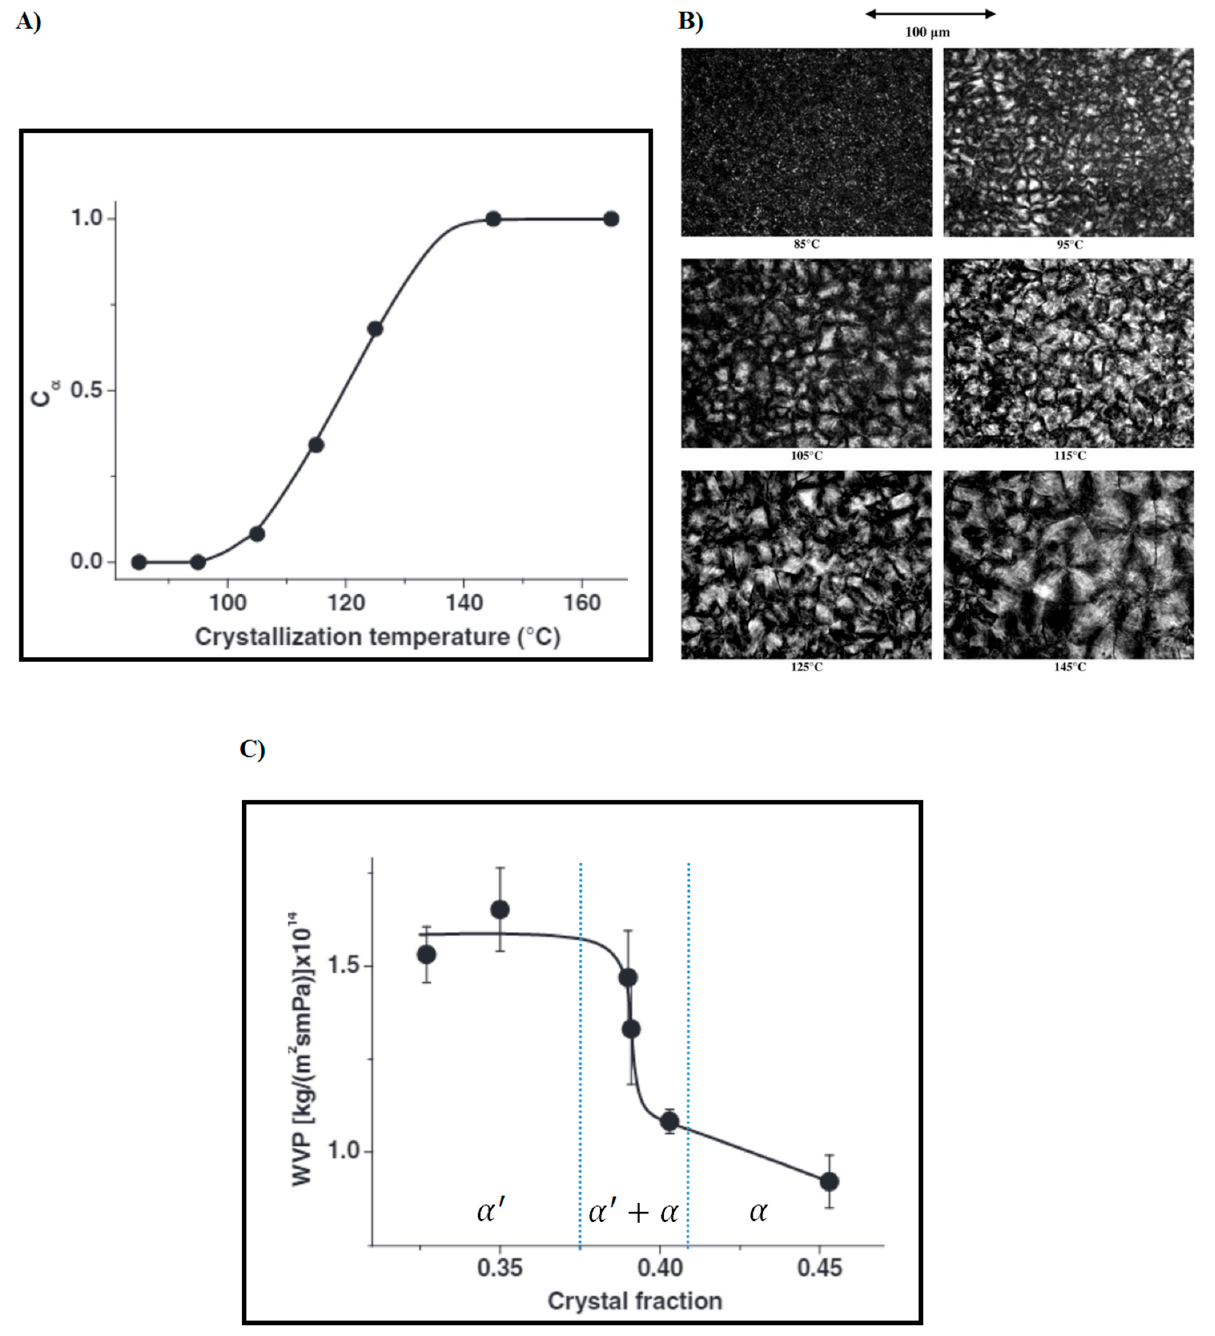
Figure 2. ( A ) Water vapor permeation estimated fraction of the α form in PLLA films; ( B ) optical micrographs of compression molded PLLA films after cold crystallization; ( C ) water vapor permeability of PLLA films crystallized as a function of degree of crystallinity. Adapted from [83] with permission from Elsevier. Copyright © 2011.